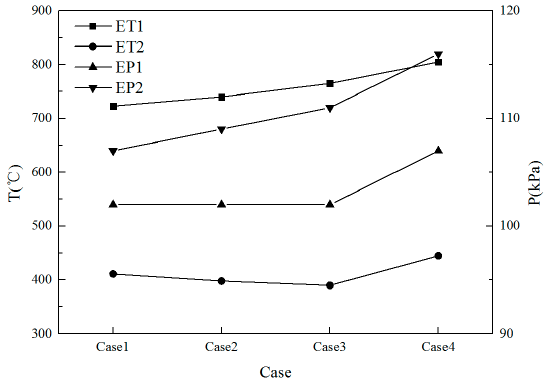
Figure 4. Exhaust pressure and temperature at the recuperator inlet and outlet. Table 5. Comparison between fuel consumption without and with the recuperator.